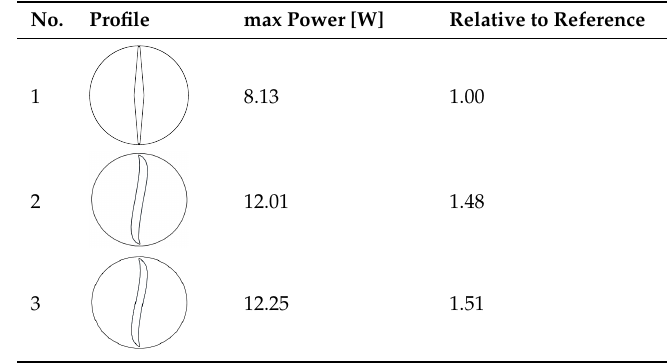
Table 4. Airfoils in comparison from the 2D simulation: Original (1); best sampling (2); and final optimization